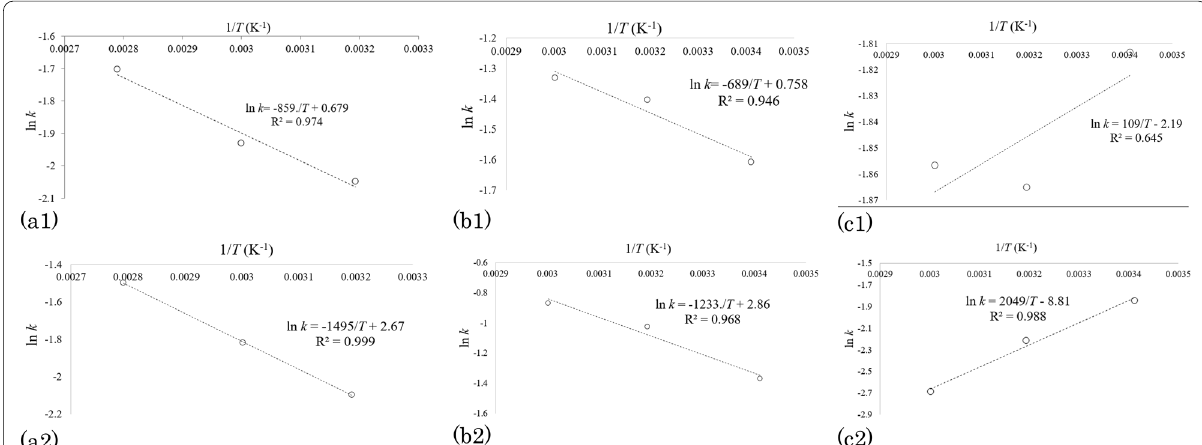
Fig. 4 Arrhenius plot obtained from first-order kinetic parameters ( a1 ) and from second-order kinetic model parameters ( a2 ) for the extraction of total polyphenolic compounds from apple pomace with water-only. Arrhenius plot obtained from first-order kinetic parameters ( b1 ) and from second-order kinetic model parameters ( b2 ) for the extraction of total polyphenolic compounds from apple pomace with 50% ethanol–50% water v/v. Arrhenius plot obtained from first-order kinetic parameters ( c1 ) and from second-order kinetic model parameters ( c2 ) for the extraction of total polyphenolic compounds from apple pomace with 65% acetone–35% water v/v